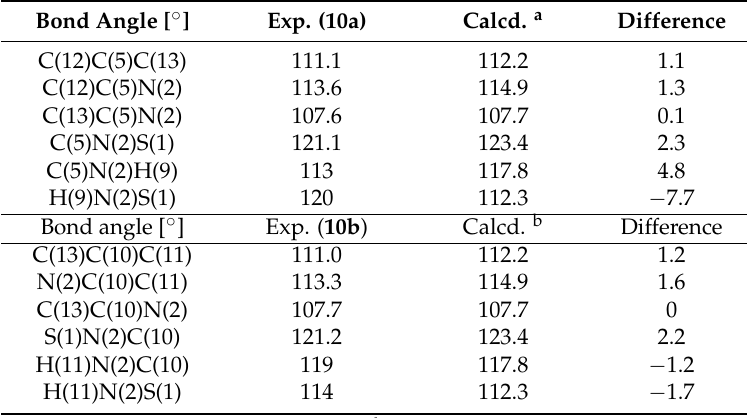
Table 3. Selected experimental and calculated geometry parameters for 10a and 10b .